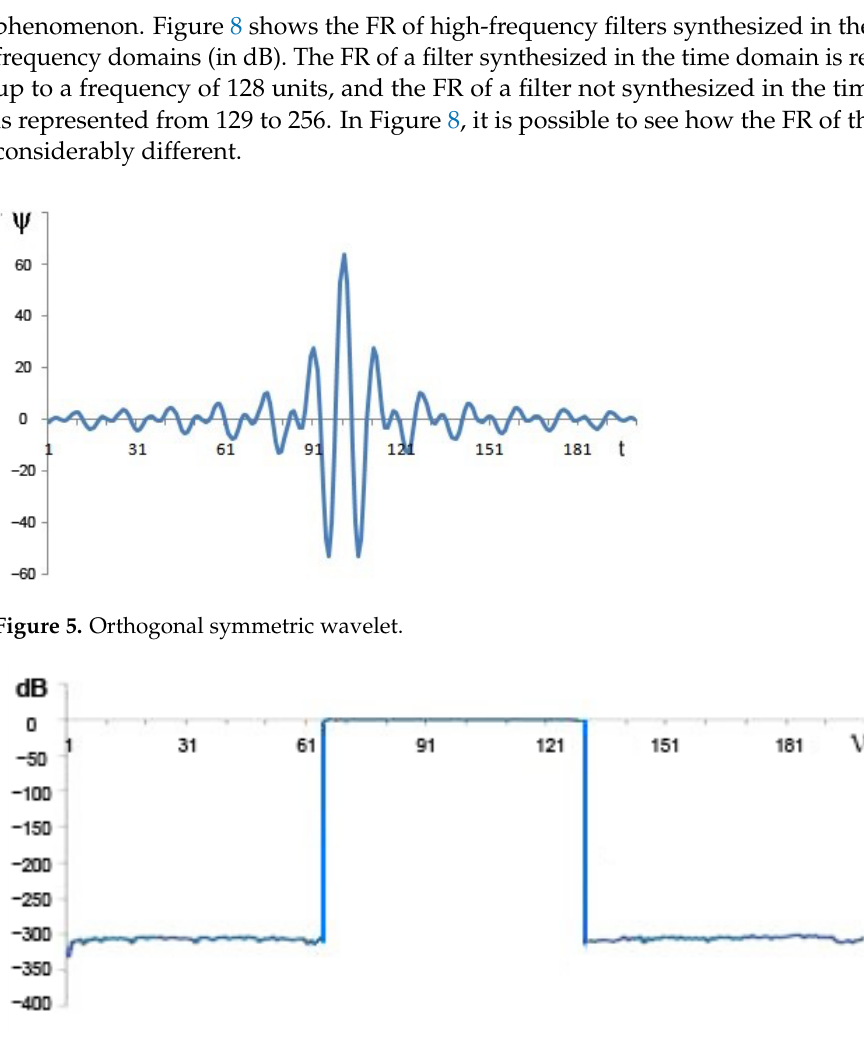
Figure 6. Frequency response in dB.